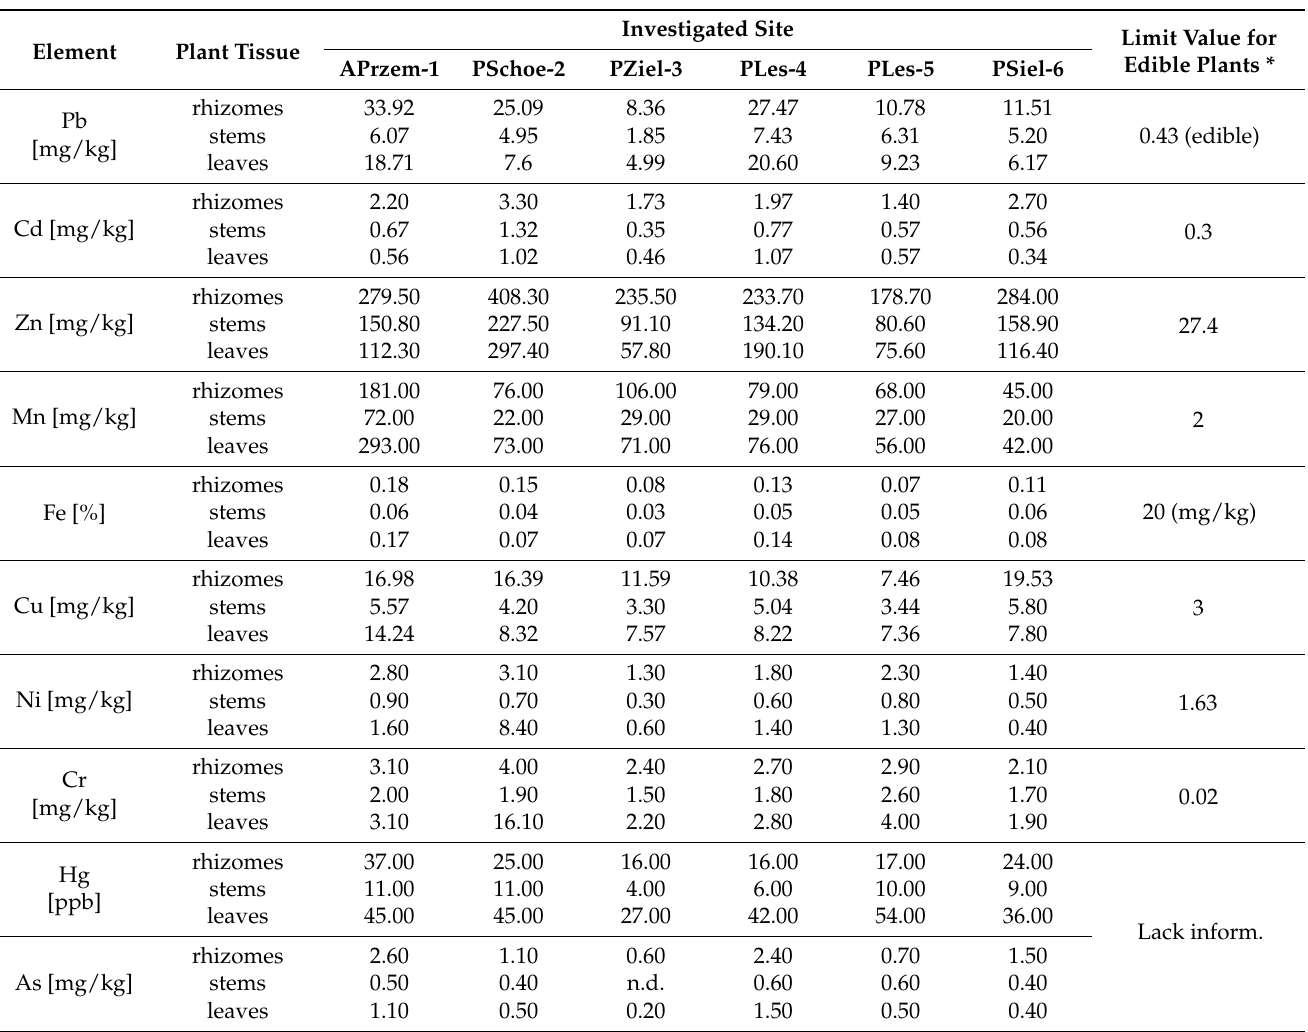
Table 5. The content of heavy metals in Ch. majus